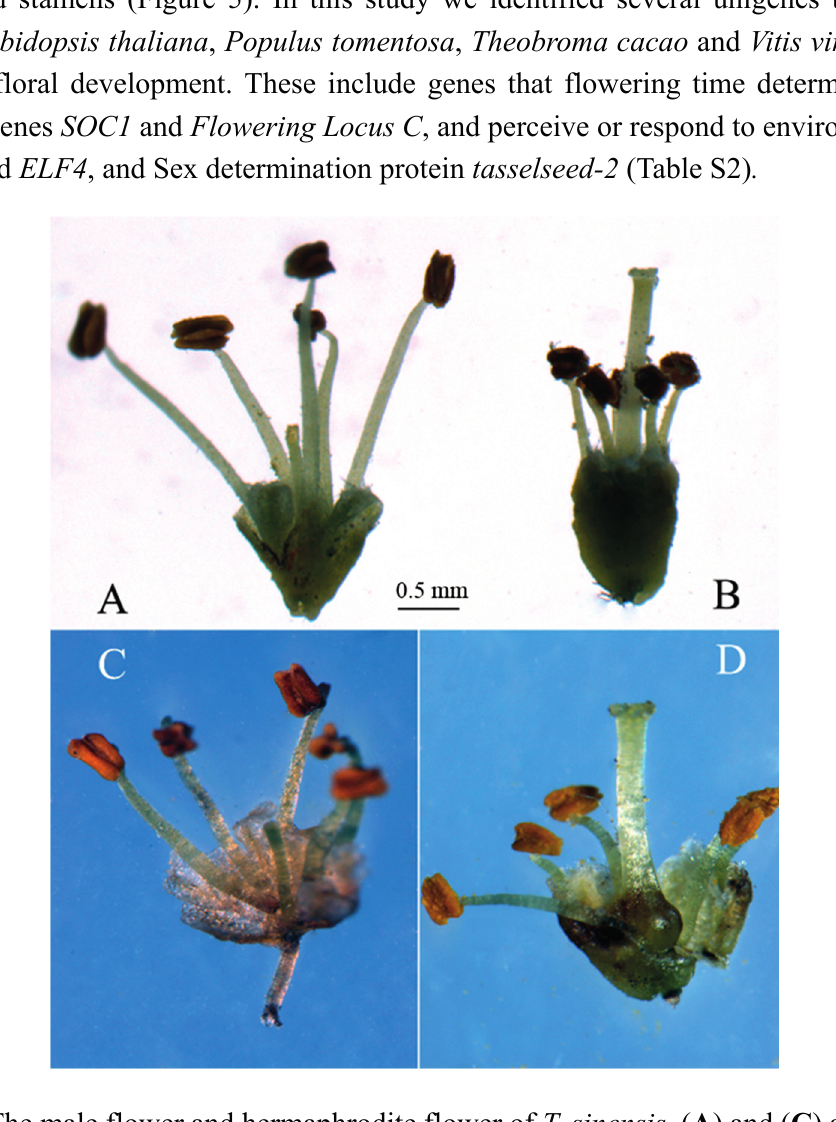
Figure 5. The male flower and hermaphrodite flower of T. sinensis , ( A ) and ( C ) are flowers from male individual; ( B ) and ( D ) are bisexual flowers from hermaphrodite